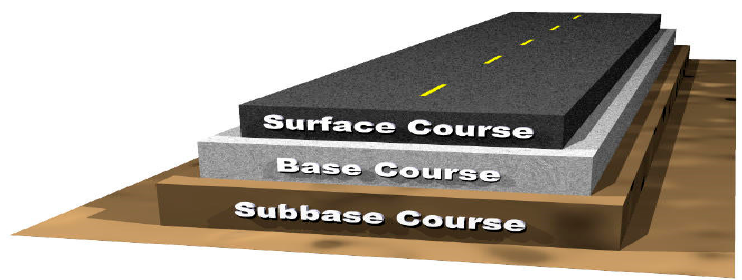
Figure 1. Pavement surface structure [4].